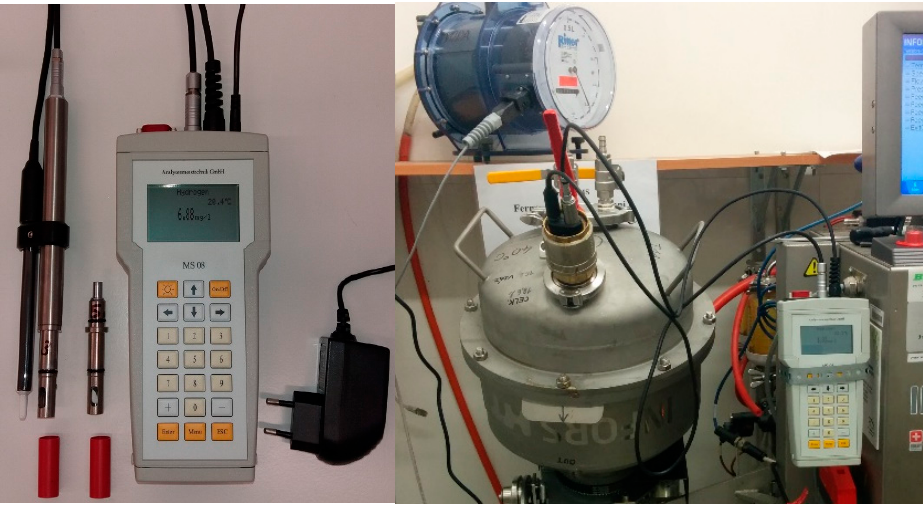
Figure 2. Amperometric microsensor and its location in the reactor.